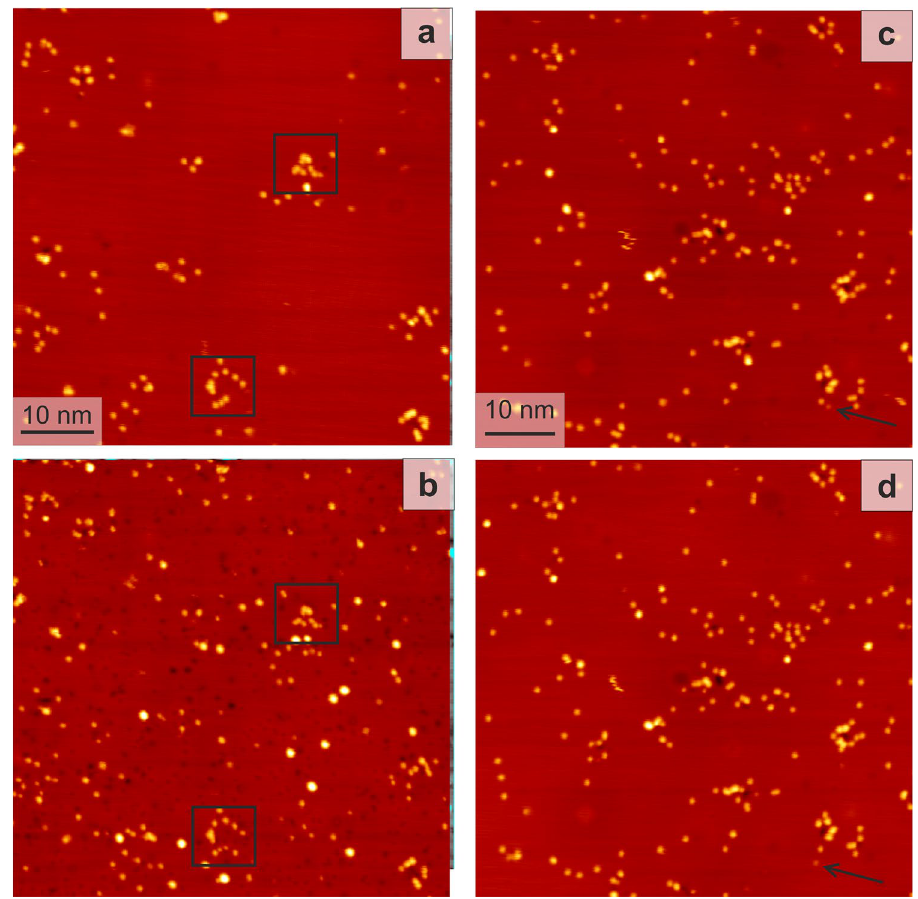
Figure 4. Laser-induced surface restructuring; 113 mV, 81 pA, 10 7 pulses: surface before ( a , c ) and after ( b , d ) laser illumination with ( a , b ) 72 fs, absorbed SPP fluence 130 µ J/cm 2 and (c,d) 250 fs, 168 µ J/cm 2 ; squares in ( a , b ) mark two sputter damages for reference; arrows in ( c , d ) mark a single moving